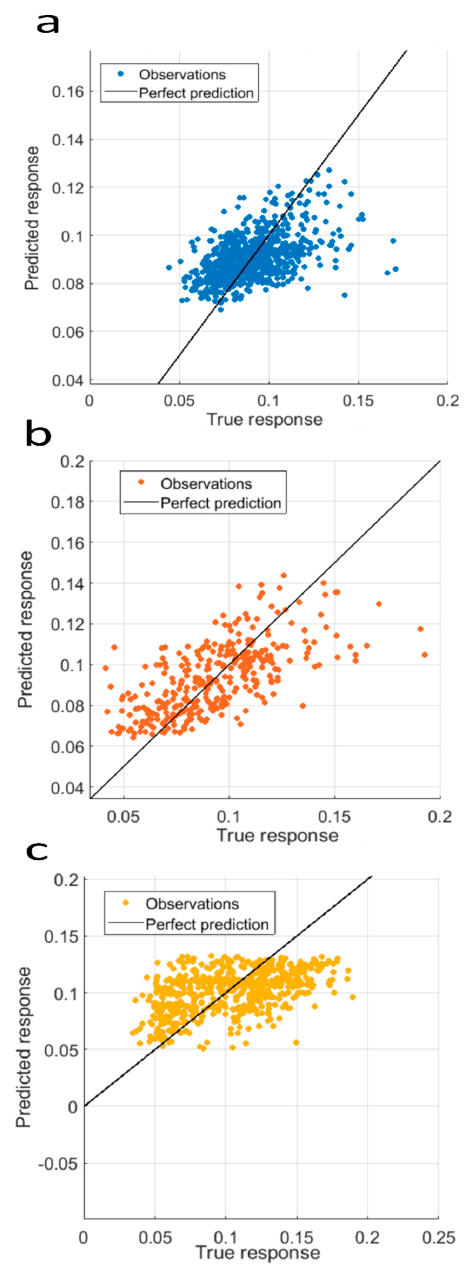
Figure 5. Linear regression performed with I / I 0 (response variable) and ∆ t (predictor) for ( a ) A 10 / T 10 (R 2 = 0.23; n = 793), ( b ) A 40 / T 40 (R 2 = 0.43; n = 332) ( c ) T 40 (R 2 = 0.23; n = 634). The results were obtained using the pore d t = 3 nm, d b = 200 nm, voltage of 500 mV.